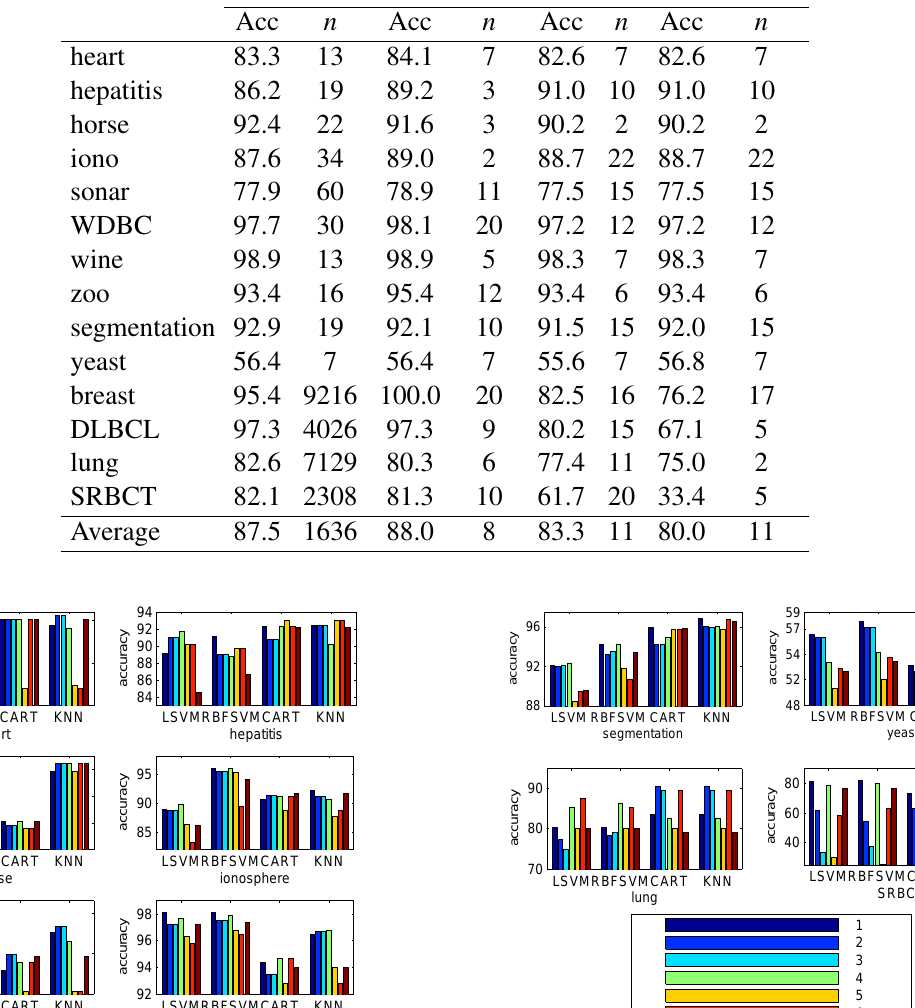
Table 2: Classification accuracy (%) with LSVM for different algorithms Data